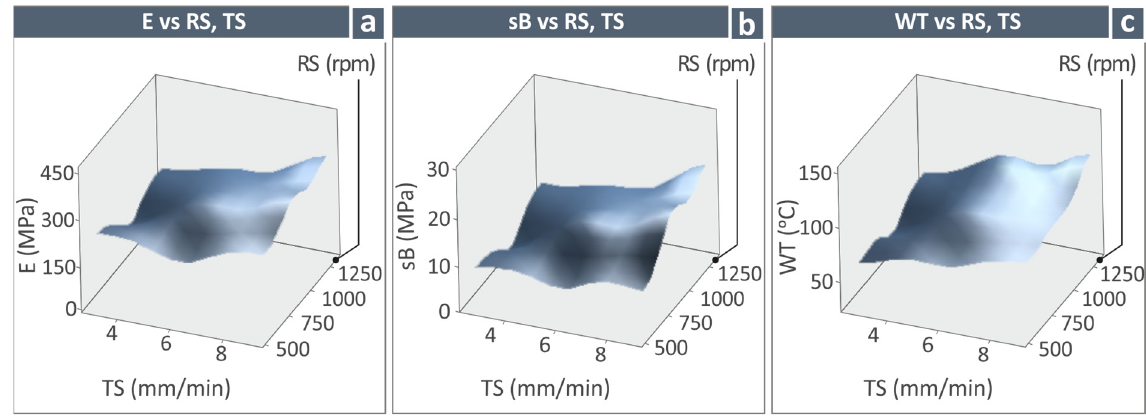
Figure 9. Surfaces plots of ( a ) E, ( b ) sB, and ( c ) WT versus TS and RS.